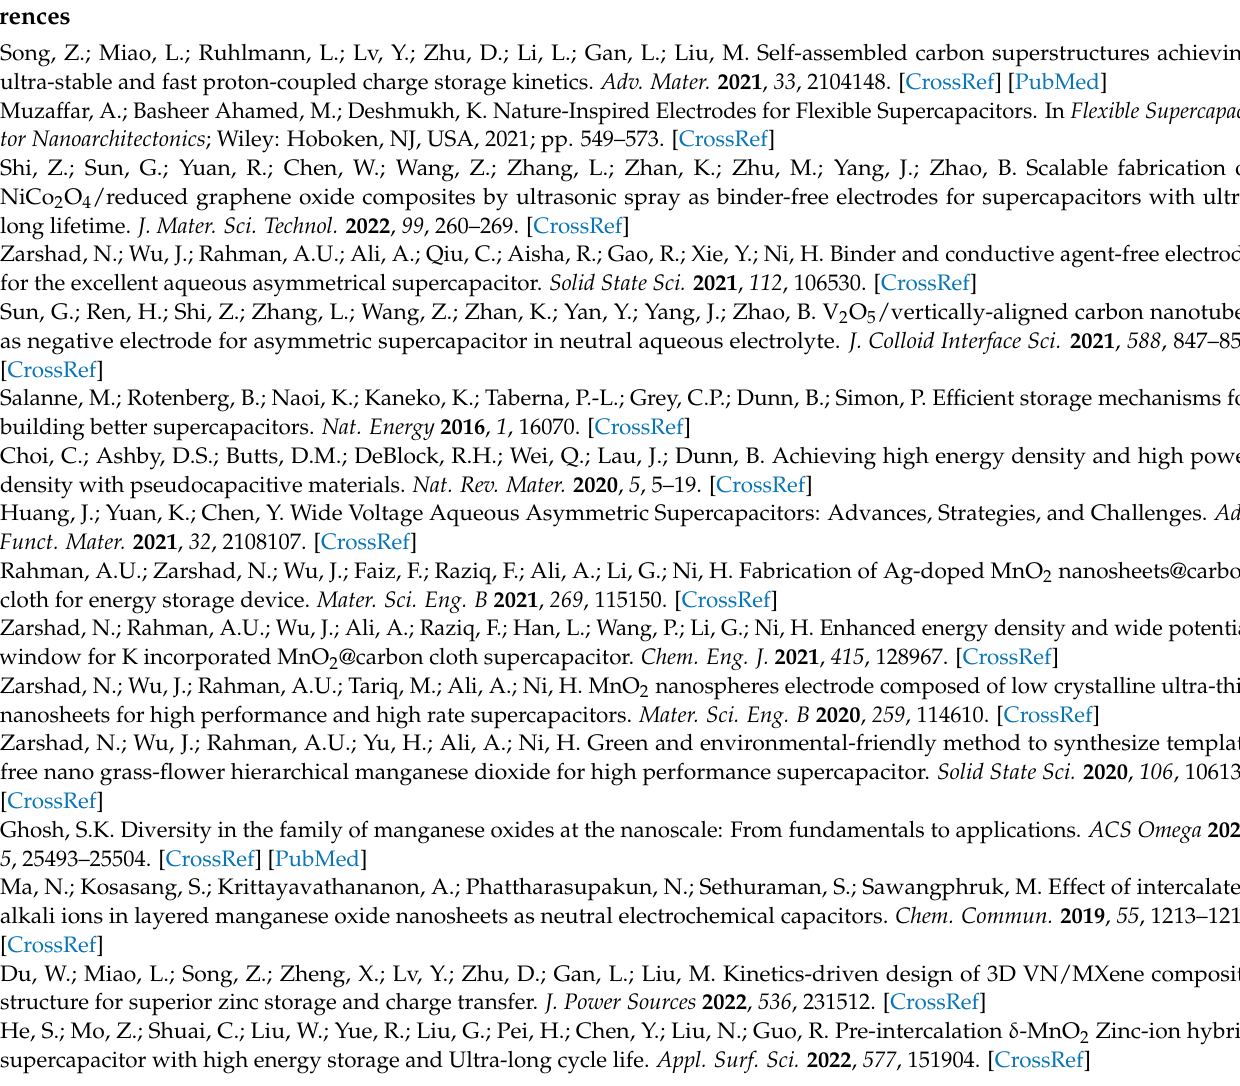
in the three-electrode system; (a) CV of the at a scan rate of 10–200 mV s − 1 in 0–1.0 V; (b) GC of the at a current density of 1–20 A g − 1 in 0–1.0 V; (c) specific capacitance as a function of current density; Figure S9. Comparison of CV curves of Na 3 -MnO 2 electrode and N-AC in their separate potential windows of 1.4–0 V and 0–1.0 V respectively at a scan rate of 10 mV s − 1 ; (b) CV curves at different potential windows from 1.6 to 2.6 V were recorded at a scan rate of 10 mV s − 1 ; Figure S10. Ragone plots of Na 3 -MnO 2 //N-AC device volumetric energy and power density; Figure S11. Cycling performance comparison at potential window of 0–1.0, 0–1.1, 0–1.2, 0–1.3, and 0–1.4